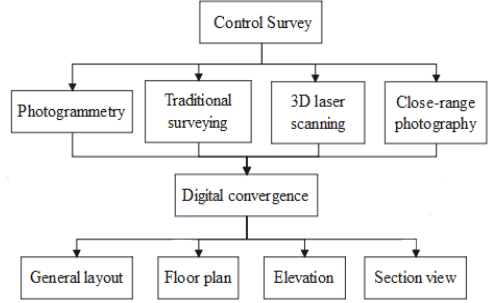
Figure 1. Overall technical route